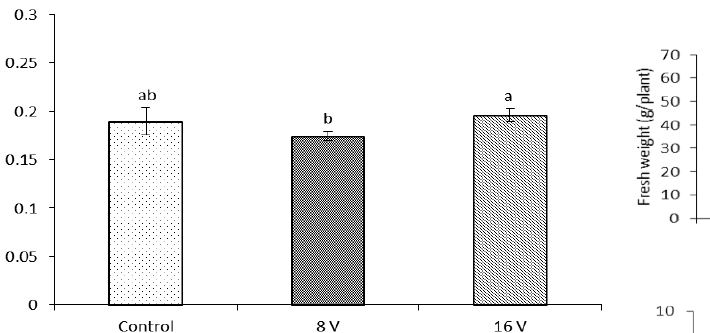
Fig. 3: Effect of different voltage applications on leaf area of African nightshade plants. Mean values (± standard deviation) followed by the same letter are not significantly different according to Tukey-test (p <